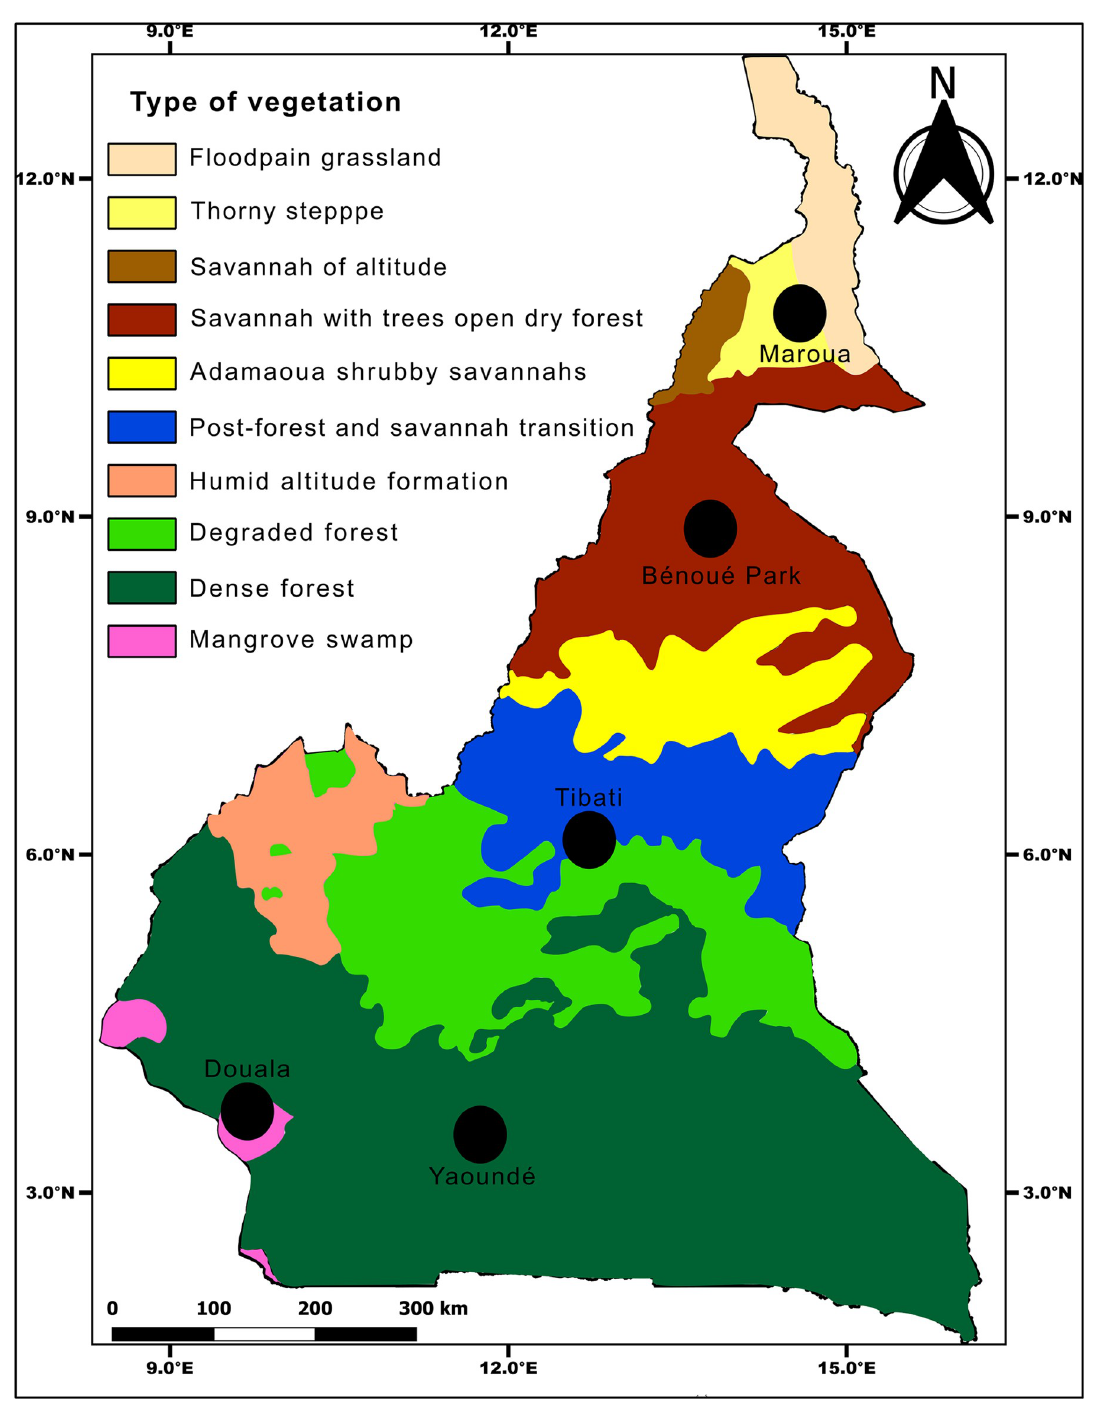
Fig 1. Map of Cameroon vegetation showing the sampling